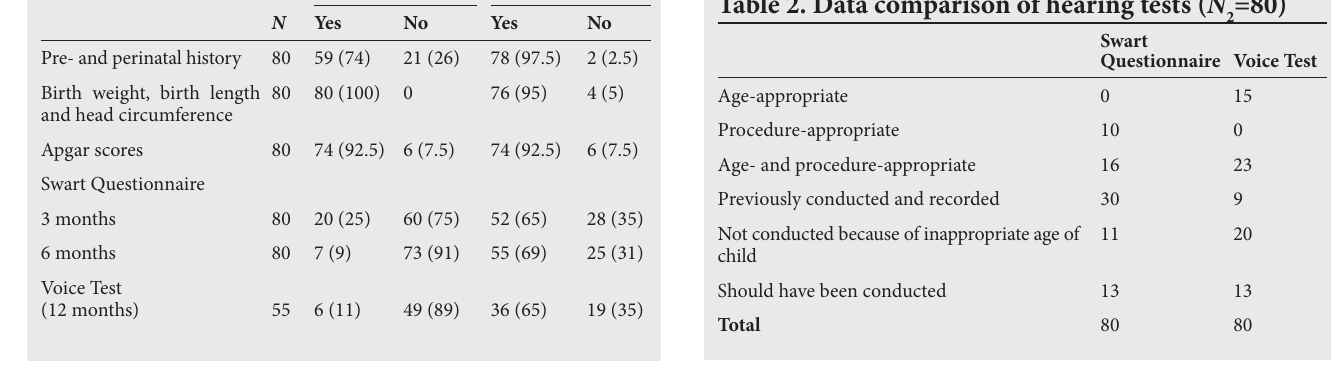
Table 2. Data comparison of hearing tests ( N